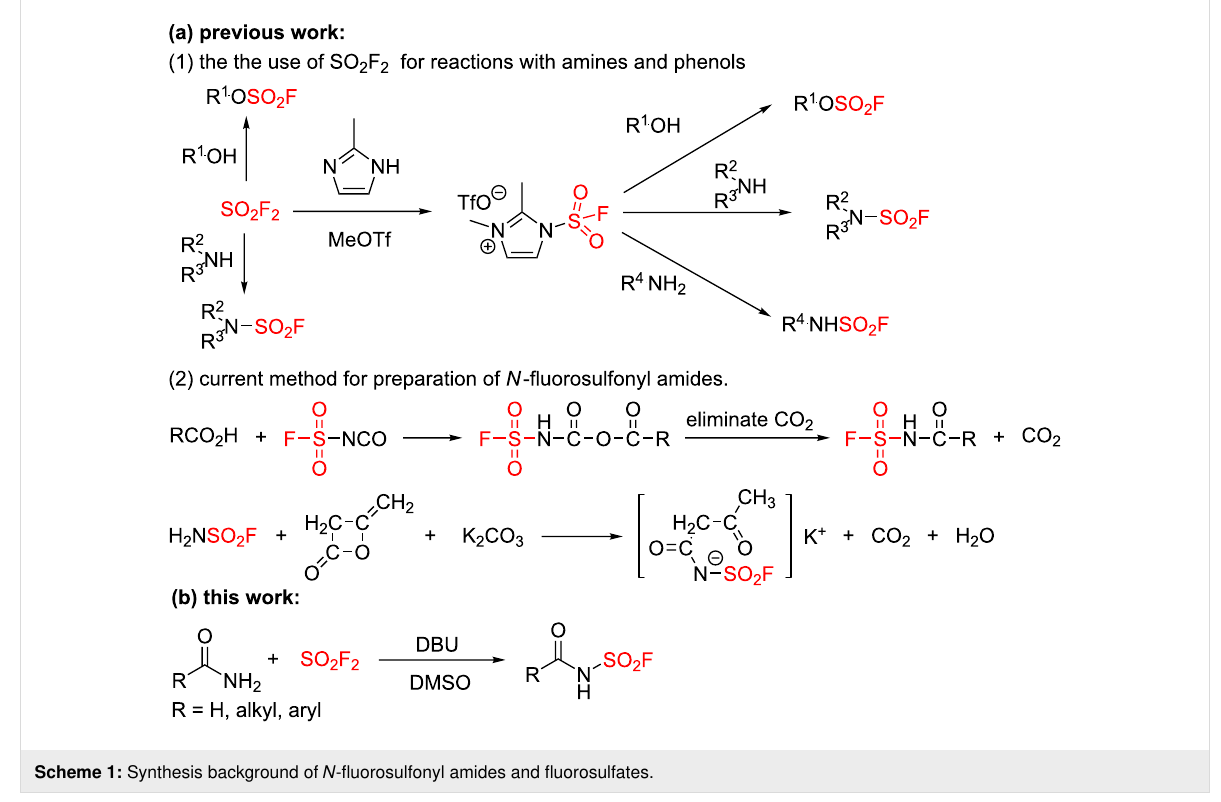
Table 1: Optimization of the reaction conditions. a